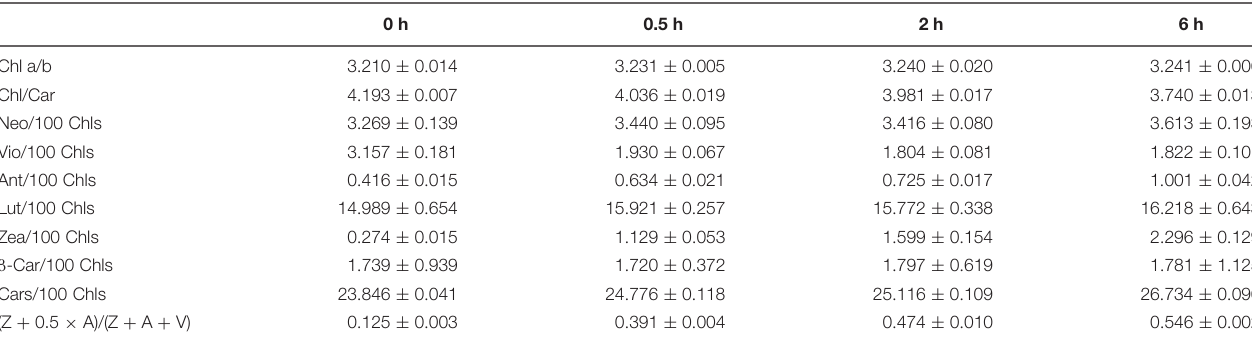
FIGURE 6 | Functional antenna size of PSII. (A) Direct measurements of chlorophyll a fluorescence in folio during a 1 s pulse in the range of 200–3500 μ mol photons ∗ m − 2 ∗ s − 1 were normalized to the PPFD. The dotted, vertical line shows the 300 μ s time point. Shown traces for six different plants (Rep1-6, respectively, represented by different line types) grown under GL1800 and measured on the axial or abaxial side of the leaf (respectively, Left and Right panel). (B) Normalized fluorescence at 300 μ s as a function of PPFD on plants from GL1800 measured on axial and abaxial side of the leaf (cyan and orange points, respectively). The linear regression fit and its error are shown as a line with a shadow. (C) The relative slope and standard error of a fit of the normalized fluorescence at 300 μ s against PPFD relationship corresponding to the functional antenna size of PSII on six different plants ( n = 6) grown under GL1800. Data normalized to GL200 measurements performed on adaxial side of the leaves. TABLE 2 | Pigment analysis during the first 6 h of